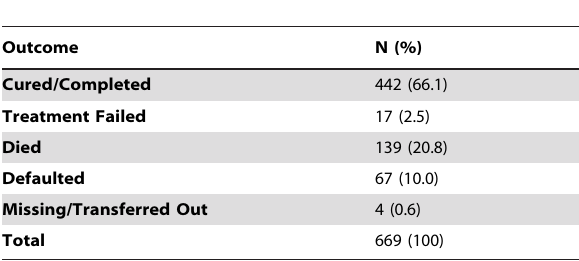
Table 2. Treatment outcomes of 669 patients enrolled in individualized treatment for MDR-TB in Peru between February 1999 and July 2002. (Adapted from Mitnick et al., 2008)